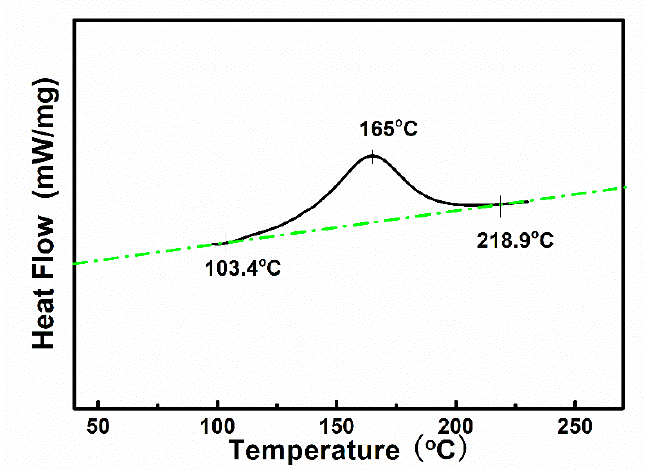
Figure 7. DSC curve of epoxy resin E51.